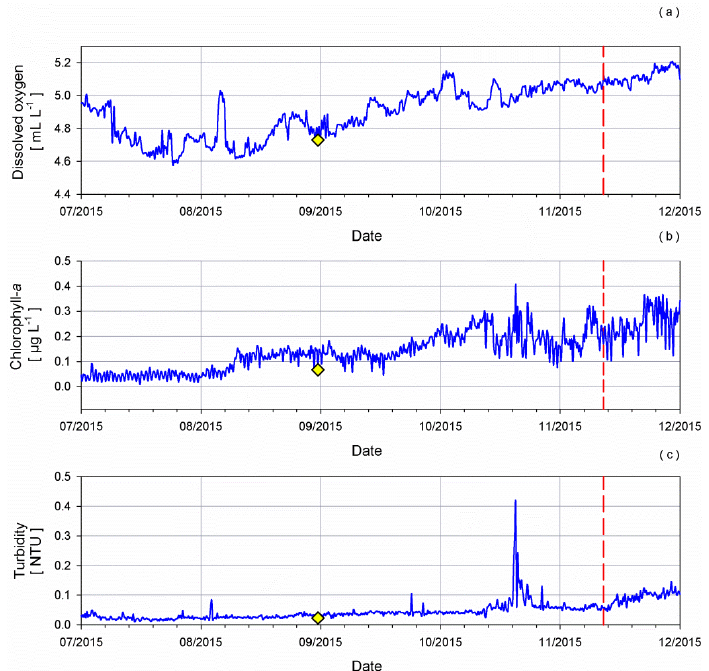
Figure 15. Time series of ( a ) dissolved oxygen, ( b ) chlorophyll- a , ( c ) turbidity acquired by the instruments installed on the W1M3A observatory at a 6 m depth. Long dashed lines correspond to the change of the sensors whereas diamonds show cast results.